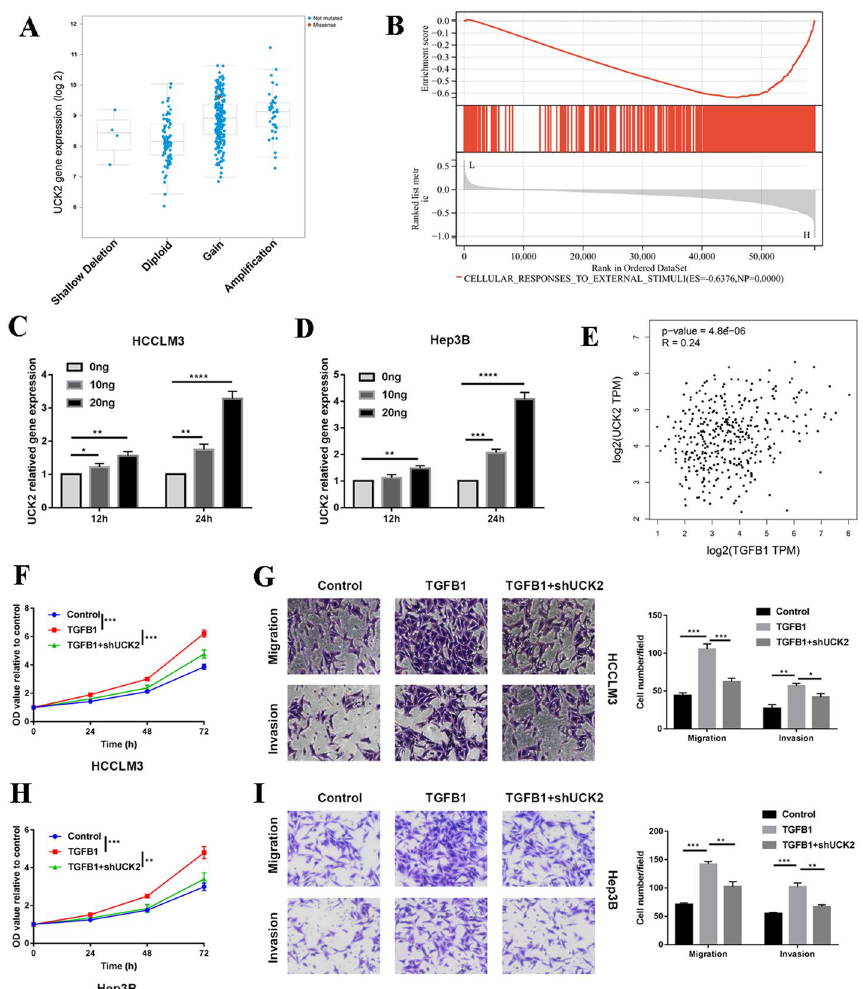
Fig. 2 UCK2 was elevated by TGFβ signalling pathway. A Gene expression of UCK2 with the copy number variation. B GSEA analysis revealed that gene expression of UCK2 was associated with extracellular stimuli. C , D 10 ng and 20 ng TGFβ1 were added to HCCLM3 and Hep3B cell lines, respectively; the gene expression of UCK2 was detected in different timepoints using qPCR. E Correlation between gene expression of UCK2 and TGFβ1. F , H CCK8 assays was used to determine the proliferation of the indicated cell lines and the value of OD450 was related to control. G , I The migration and invasion abilities of the indicated cell lines were detected by Transwell assays in the left panel, and the statistical analysis is presented in the right panel. * p < 0.05; ** p < 0.01; *** p < 0.001; **** p <